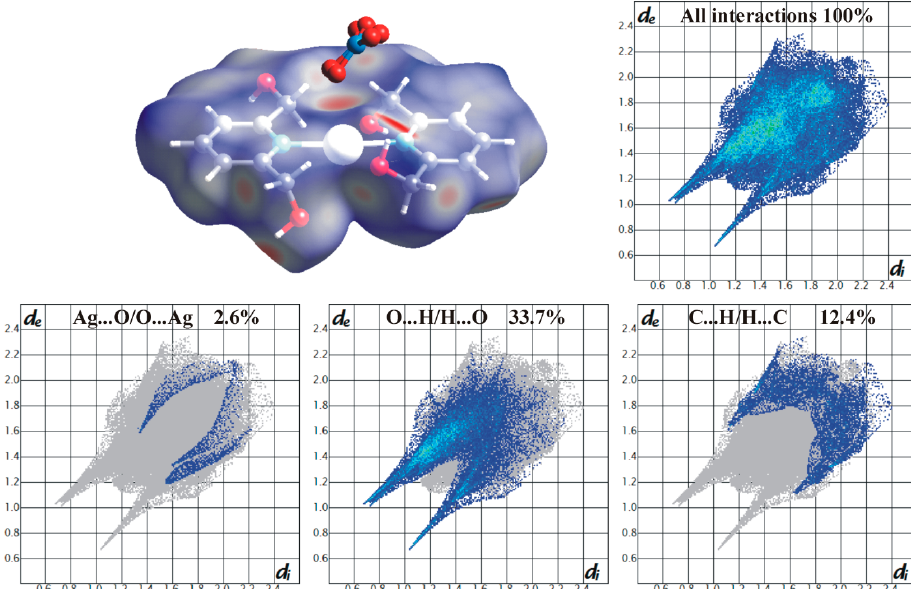
Figure 3. Hirshfeld surface of Ag(I) complex-cation molecule with the geometrical function d norm mapped onto it (a colour scale from red to blue: − 0.75 Å–1.2 Å) and corresponding finger plots indicating